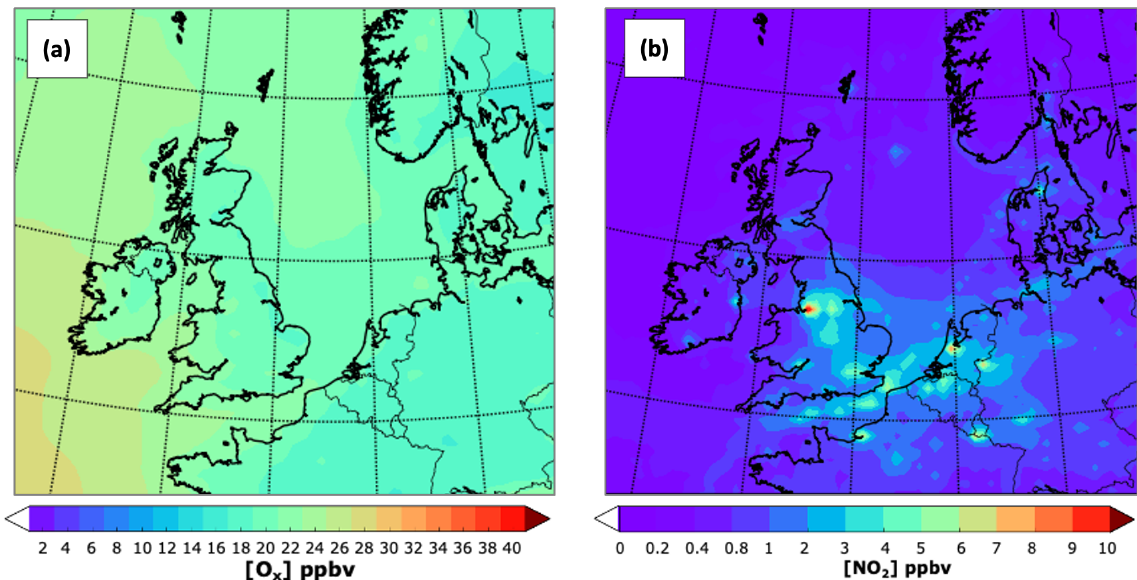
Figure 7. Close-up of the spatial distribution for July 2015 of (a) the lateral-boundary mean O x mixing ratio (O 3 + NO 2 ) and (b) NO 2 . Note the different scales in (b) .